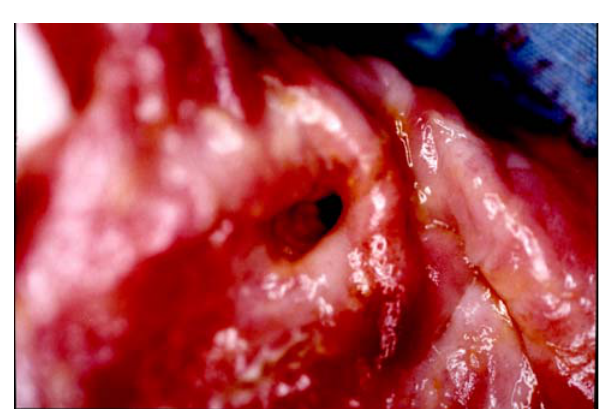
FIGURE 13 - Foley catheter is occluded four cm above the skin.